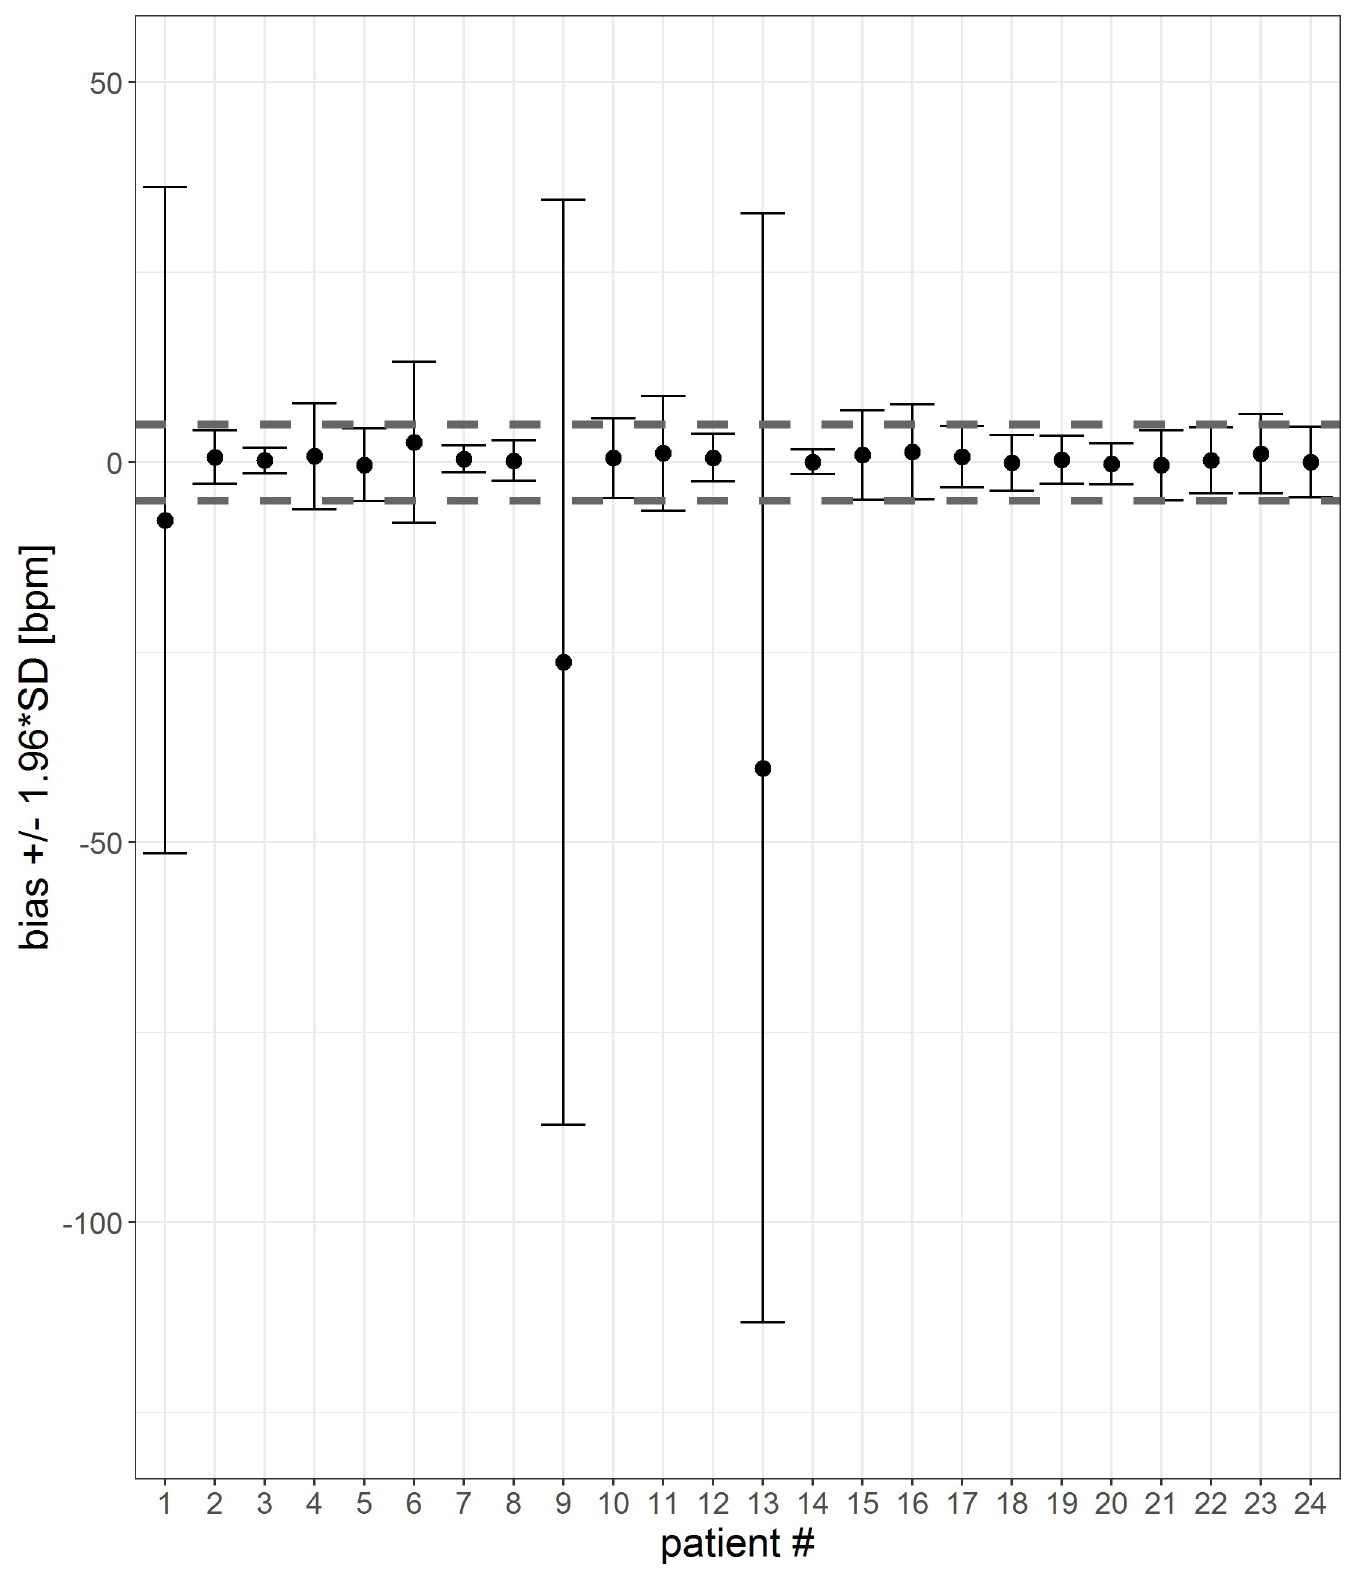
Fig 6. Error bar of each patient for a 1-sec-interval. The mean differences and confidence interval (bias +/- 1.96 � SD) for each patient are plotted. Difference was calculated by subtracting patient monitor data from Healthdot data, based on a1-sec-interval. The gray dashed lines indicate the required threshold of 5 bpm. https://doi.org/10.1371/journal.pone.0247903.g006 PLOS ONE | https://doi.org/10.1371/journal.pone.0247903 April 28,